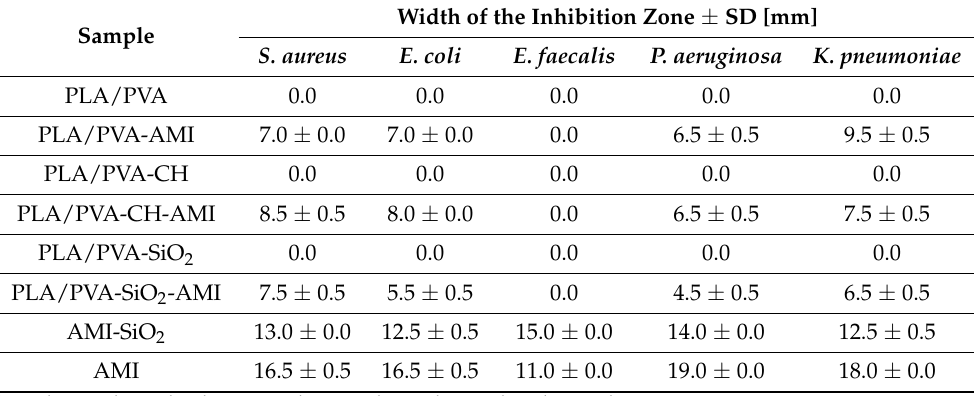
Table 4. Antibacterial activity of fabricated porous